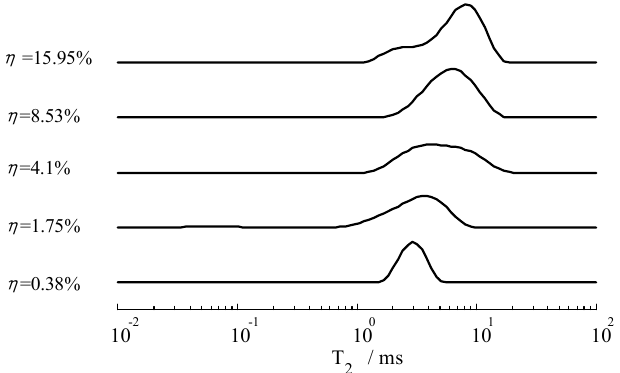
Figure 11. T 2 spectrum curves of the sandy soil with different moisture content.